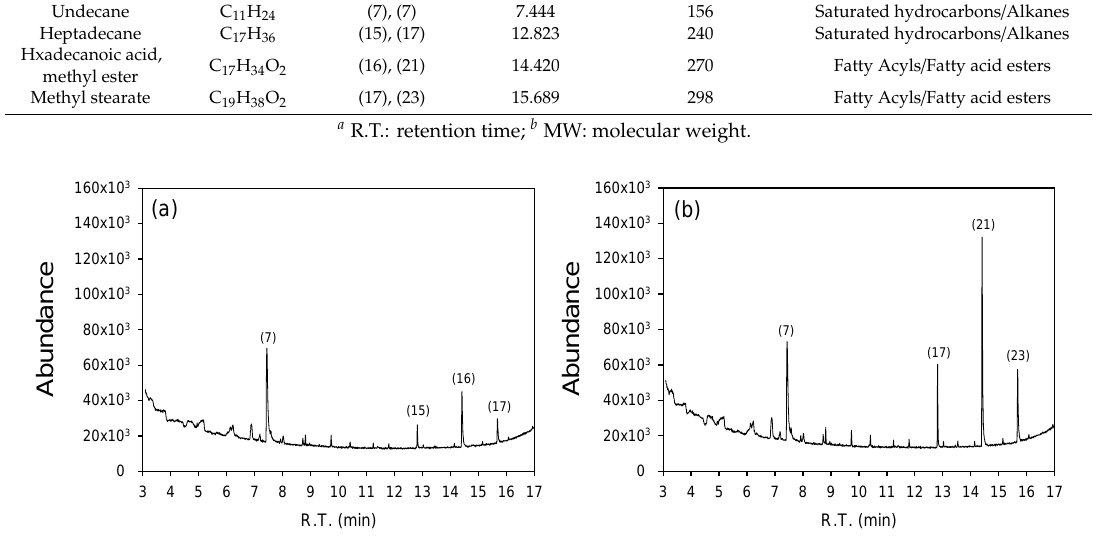
Figure 6. GC/MS result of the harvested MB samples ( a ) MB 2 and ( b ) MB 3 . R.T. means retention time.